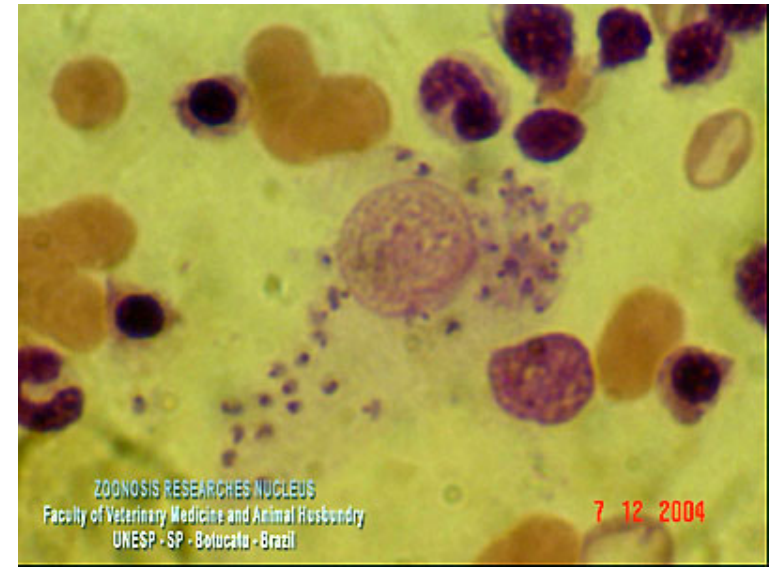
Figure 4: Amastigote forms of Leishmania sp from bone marrow aspirate, stained by the Giemsa method